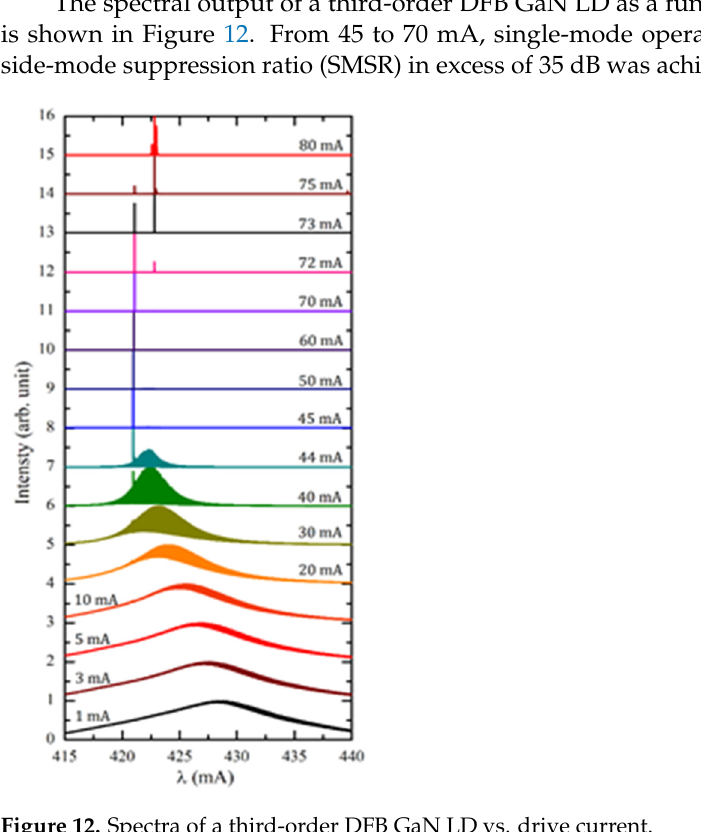
Figure 12. Spectra of a third-order DFB GaN LD vs. drive current.